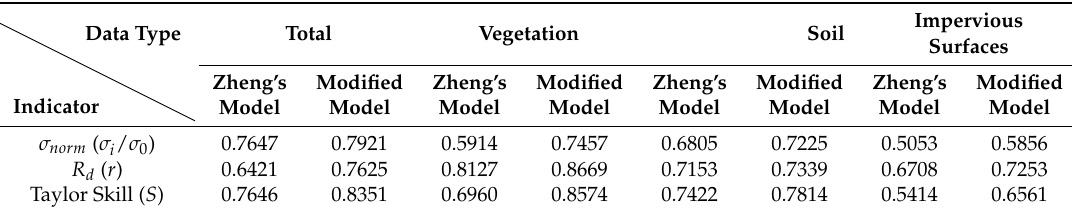
Figure 17. Performance of the inversion values inferred from the modified model and Zheng’s model (the statistics in the Taylor diagram); an ideal model would have a standard deviation ratio ( σ norm ) of 1.0 and a correlation coefficient of 1.0 (REF is the reference point). Table 10. Indicators of the Taylor diagram.